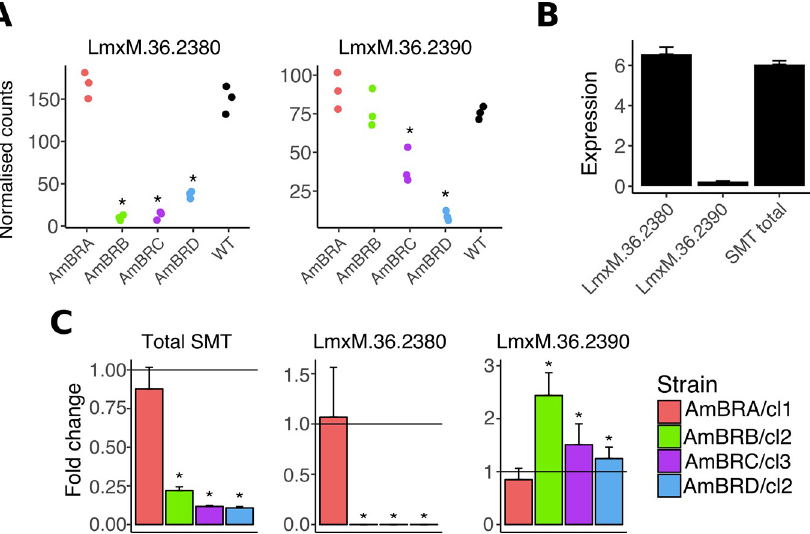
Fig 3. Changes to SMT expression. A) Expression of SMT genes LmxM . 36 . 2380 and LmxM . 36 . 2390 , expressed as normalised counts for individual clones for resistant lines (three independent biological replicates for wild-type). Asterisks represent corrected P values < 0.05. See Supplementary data for full statistical information. B) Wild-type promastigote expression of SMT genes, expressed as fold-expression over GAPDH. Initial Ct values were normalised to standard curves of genomic DNA to allow direct comparison of different qPCR targets (overall SMT values were altered by a factor of two to account for two gene copies), followed by division by similarly normalised values for GAPDH. Note that there is no significant difference (P > 0.05, two-tailed student’s t- test) in values for LmxM . 36 . 2380 and total SMT expression. C) Expression of SMT genes in AmB-resistant lines, as determined by qRT-PCR. Asterisks denote statistically significant differences (P < 0.05) in δ Ct from wild-type, n = 3. P values for statistical changes were as follows for AmBRB/cl2, AmBRC/cl3 and AmBRD/cl2, respectively: for overall SMT, 4.68 x 10 − 6 , 9.70 x 10 − 6 and 1.58 x 10 − 6 ; for LmxM . 36 . 2380 , 4.05 x 10 − 5 , 2.21 x 10 − 4 , and 0.00318; for LmxM . 36 . 2390 , 4.71 x 10 − 4 , 0.0228 and 0.0430. See Methods for the statistical approach used.